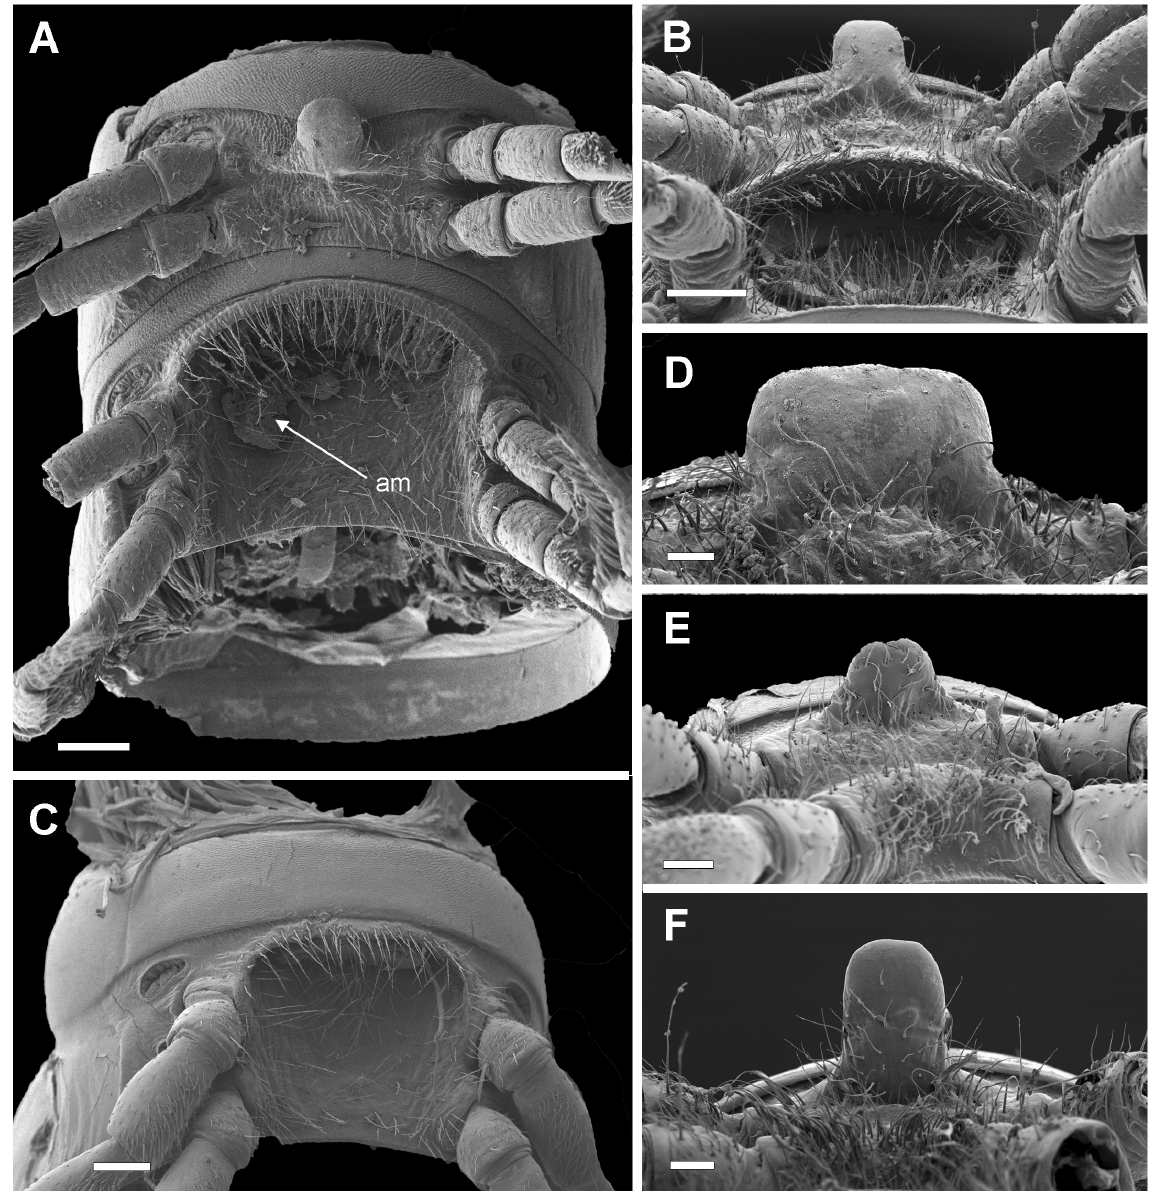
Fig. 6. Eviulisoma spp., male sternum 5 with lobe between 4th legs and sternum 6 with